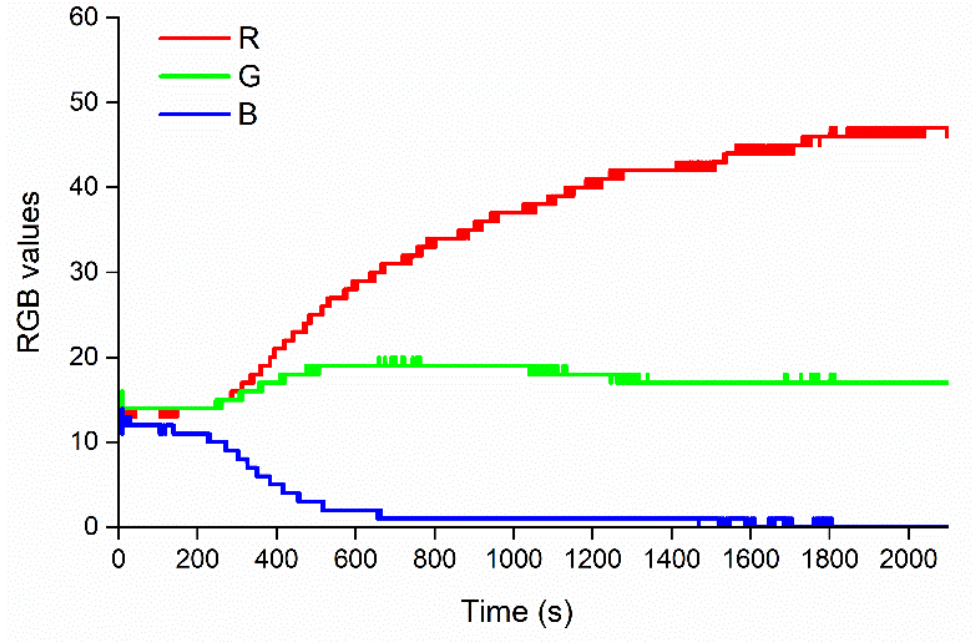
Figure 4. RGB kinetics of the exposure of Harrison’s reagent embedded into a screen-printed TiO 2 film to 50 ppm phosgene vapors. film to 50 ppm phosgene